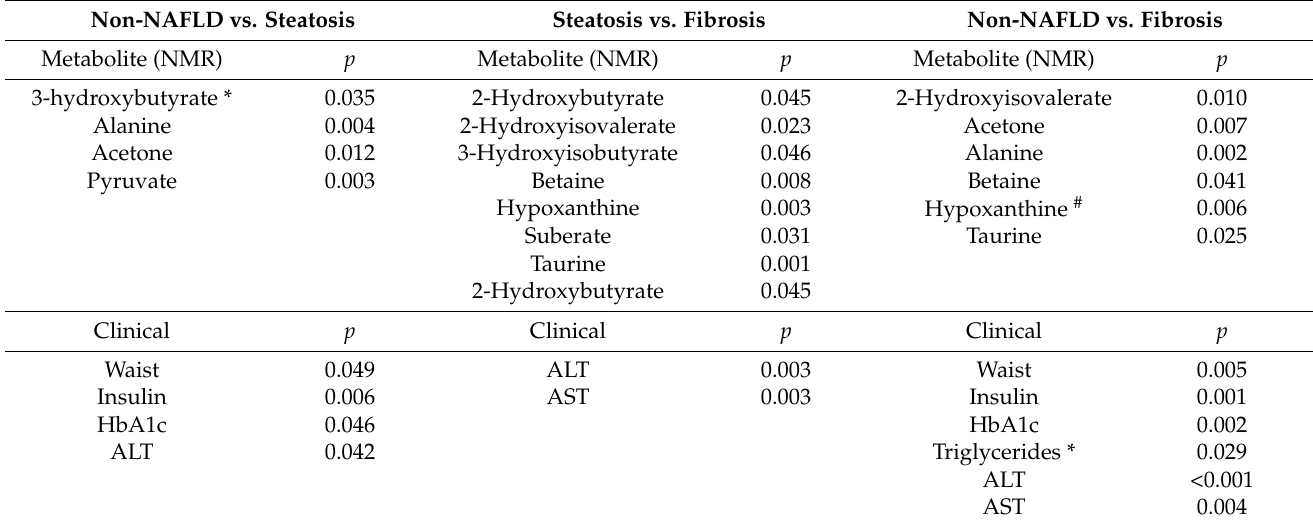
Table 3. Independent-samples t -tests among the three groups (Table